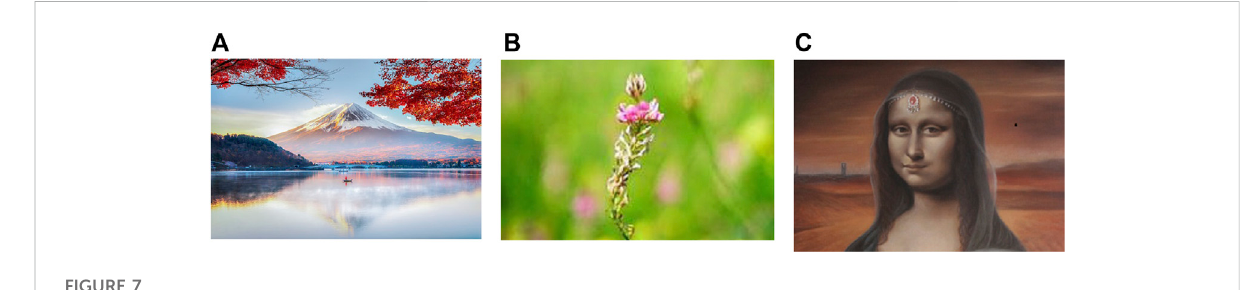
FIGURE 7 Figures A – C represents the set of cover images used in the tests performed.